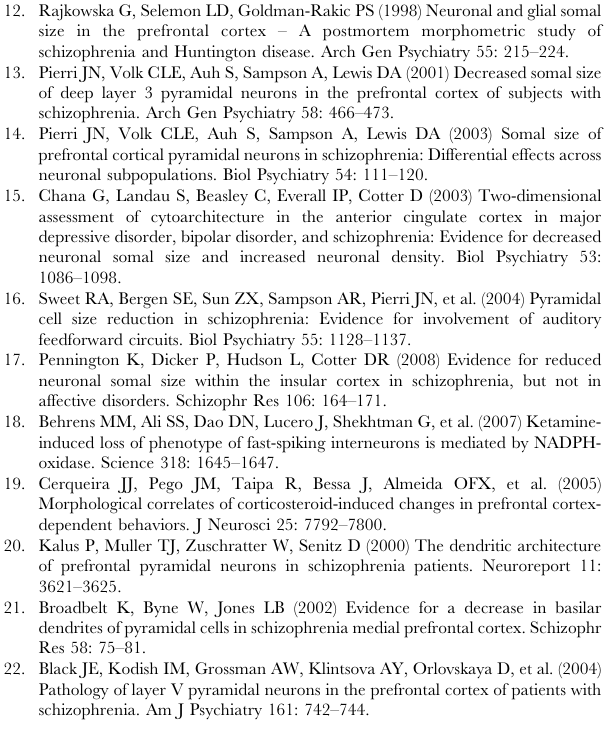
Table S1 Pathway analysis of the SMRI Array database identified 17 apoptotic pathways of potential interest. Table S2 Demographic and clinical variables of groups included in the SMRI collection. Table S3 Demographic and clinical variables of groups included in the NSW TRC